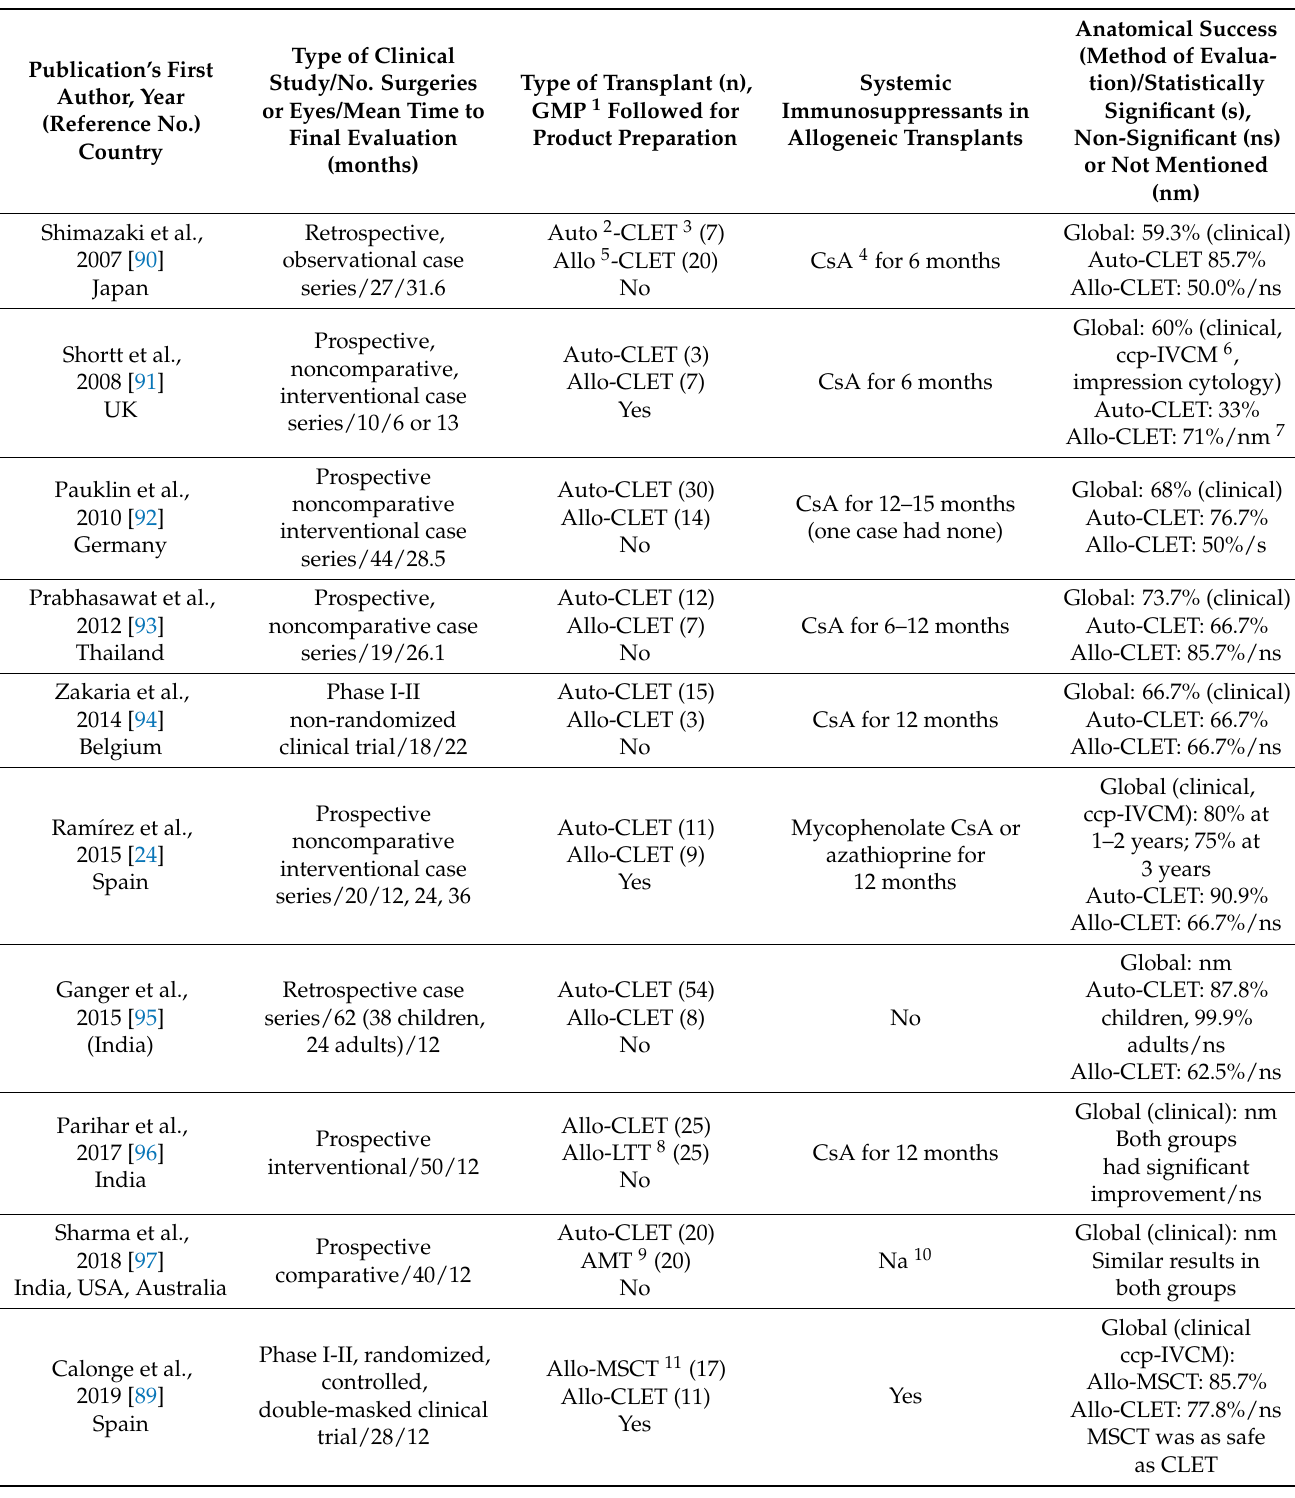
Table 1. Published studies using stem cell-based transplants compared with other techniques (in at least five eyes) in the management of severe limbal stem cell deficiency